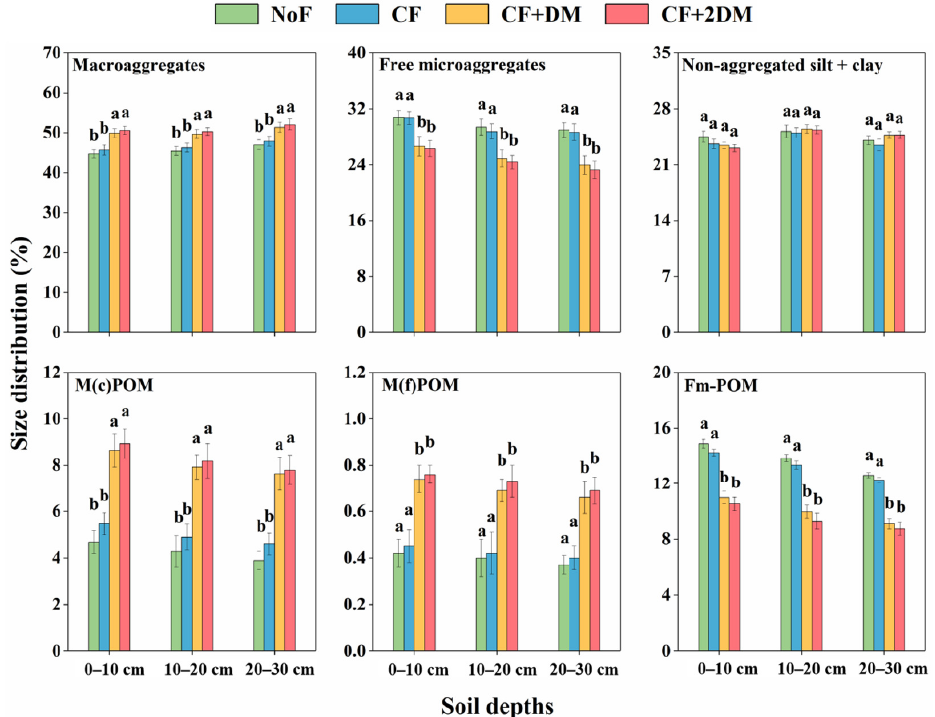
Figure 4. Size distribution within hierarchical aggregates under the four fertilization managements. In the same soil layer, the various letters of the same fraction exhibited significant differences at the p < 0.05 level via Tukey’s HSD test under the four treatments. NoF, non-fertilizer. CF, only chemical fertilizer. CF + DM, chemical fertilizer plus with single dairy manure. CF + 2DM, chemical fertilizer plus with double dairy manure. The specific meanings of organic matter fractions with abbreviations are presented in Table